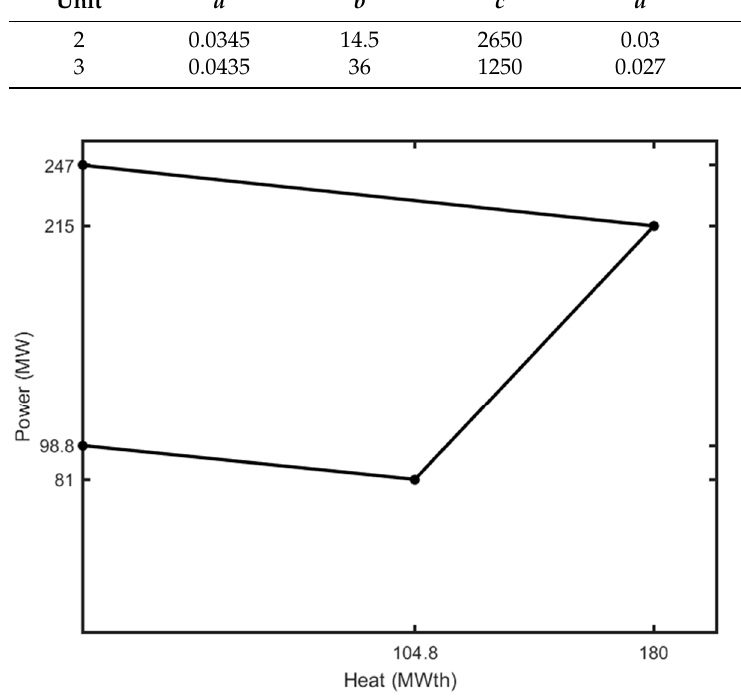
Figure 5. Feasible operating area of Heat-power in unit 2.